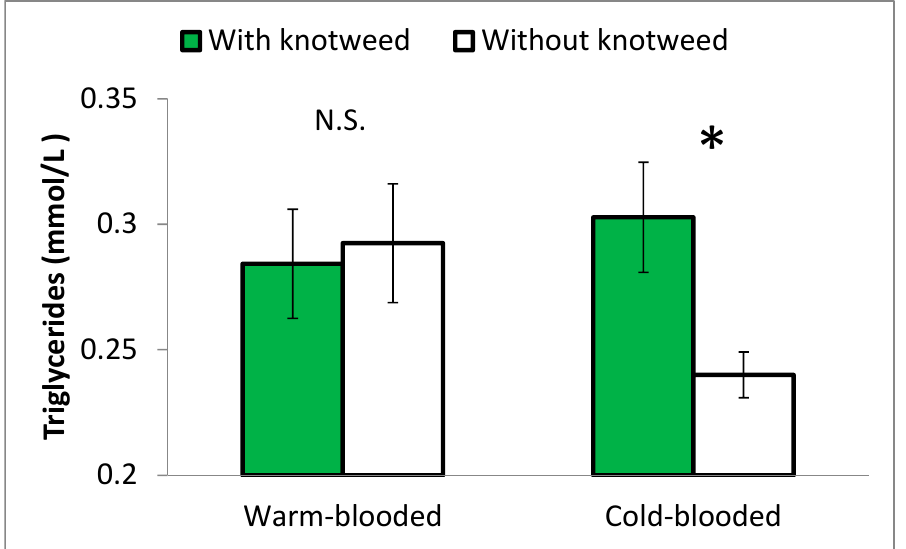
Figure 6. Levels of triglycerides at the end of Experiment 2 in the blood of horses fed and not fed knotweed. Warm-blooded and cold-blooded horses were compared. Statistically different values at p ≤ 0.05 are marked with *. N.S. = non-significant difference.